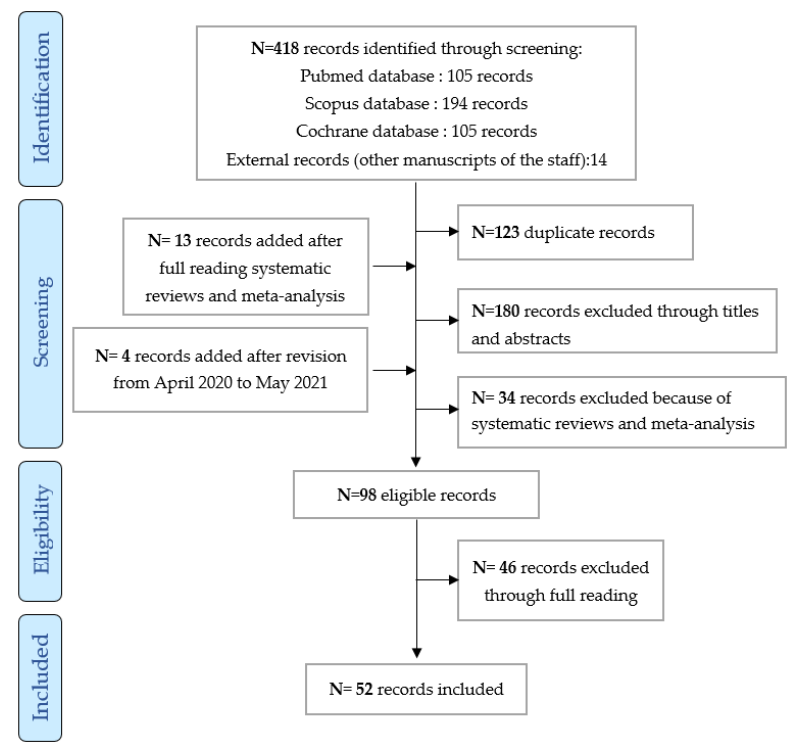
Figure 1. Inclusion diagram of the studies analyzed from May 2010 to May 2021.